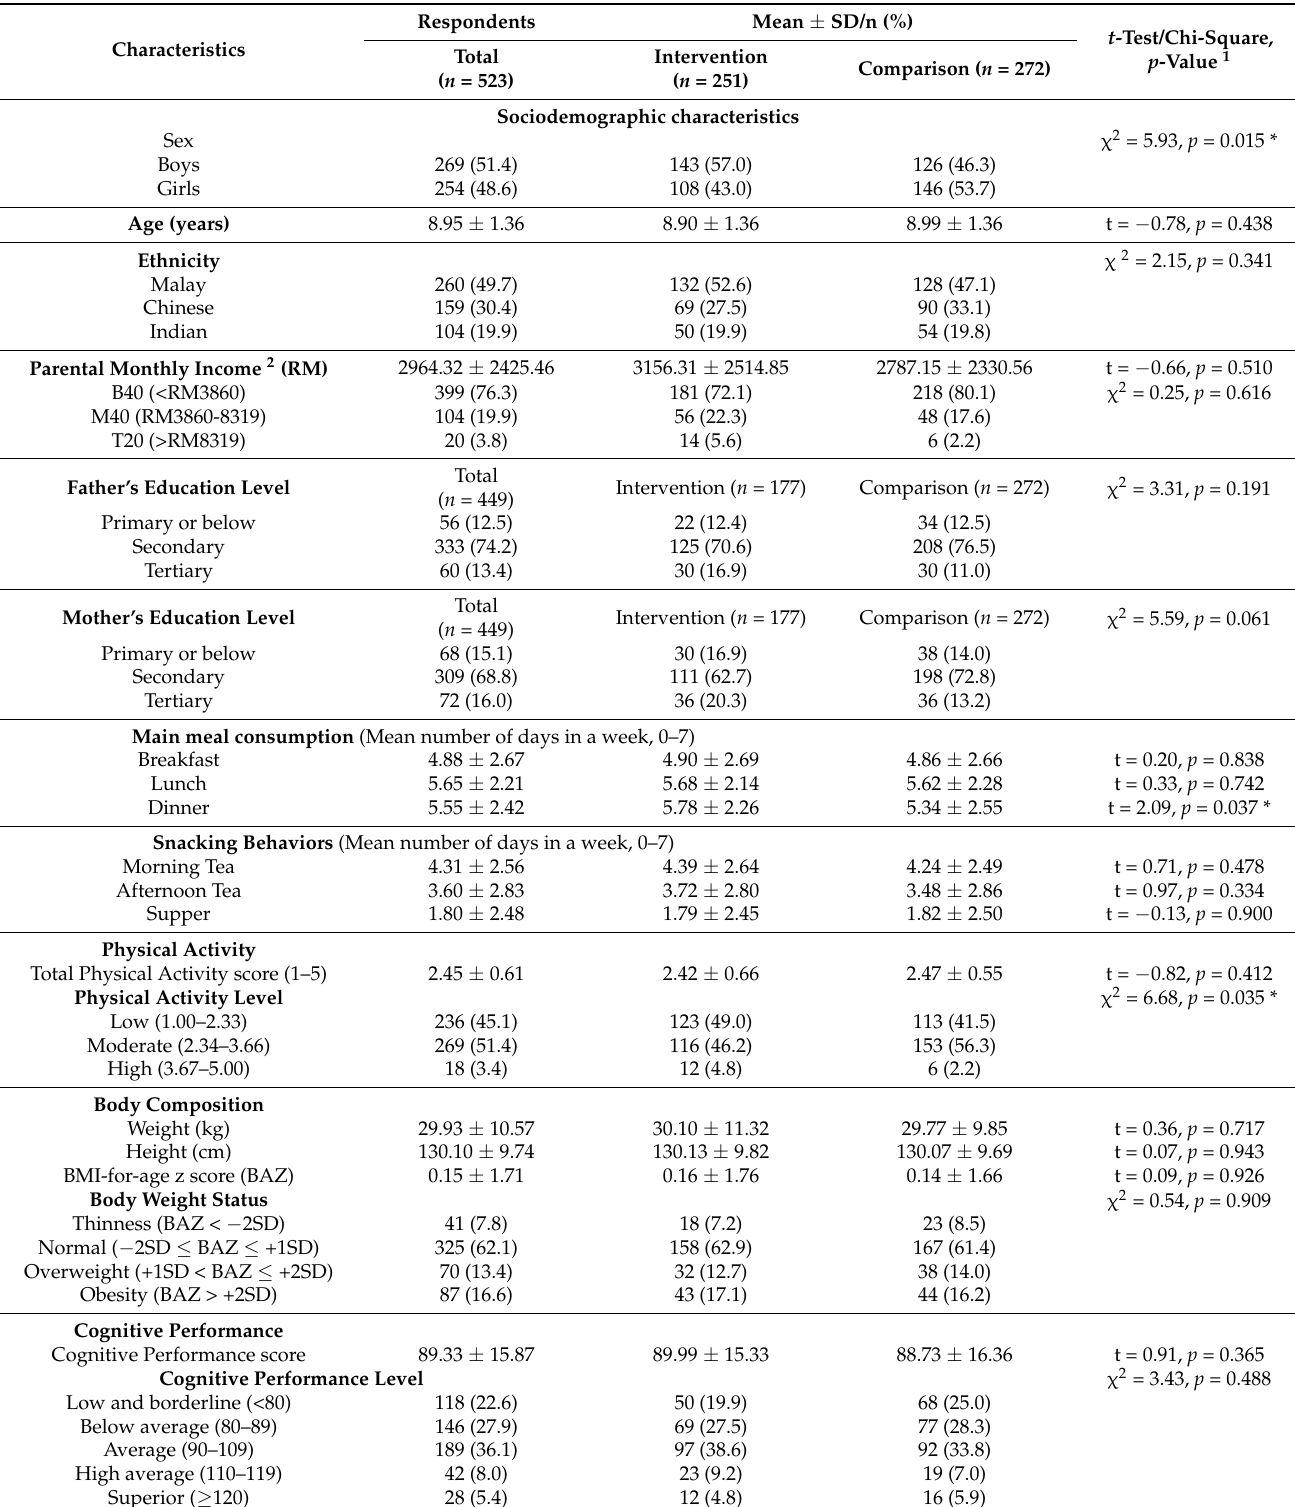
1 Comparison of pre-intervention characteristics between IG and CG was performed for continuous and categorical variables by using an independent sample t-test and chi-square tests. Significant differences between IG and CG were determined at p -value < 0.05. 2 Based on data from Department of Statistics Malaysia (2018), parental monthly income was categorized into B40 (<RM 3860), M40 (RM 3860—RM 8319), or T20 (>RM 8319)